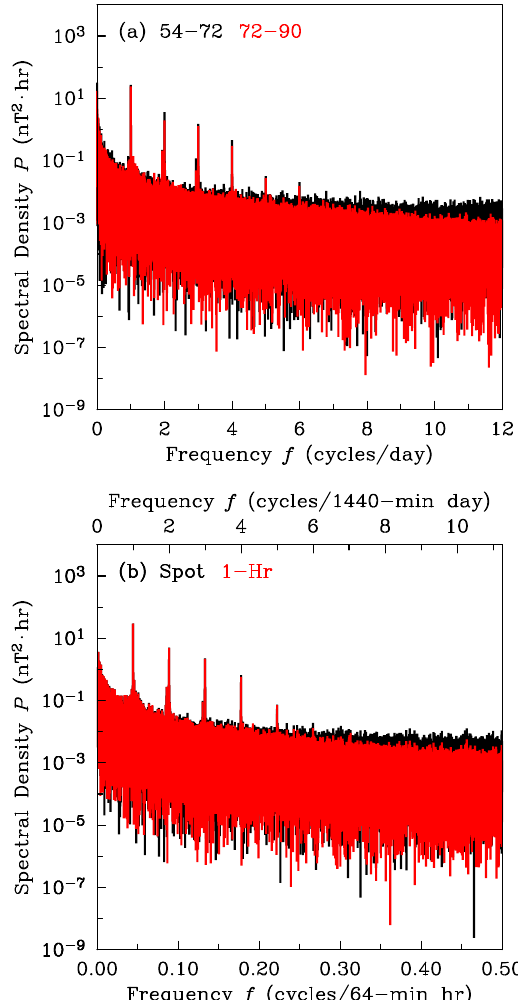
Fig. 1. Comparison of (a) power spectral density P H (f ) as a func- tion of frequency f for historical hourly CLF- H data for years when instantaneous “spot” values were reported, 1954.0–1972.0 (black), and when 1-h average-samples were reported, 1972.0–1990.0 (red); (b) synthetic spot samples (black) and 1-h average-samples (red), each constructed from 1-min CLF- H data, 1991.0-2009.0.